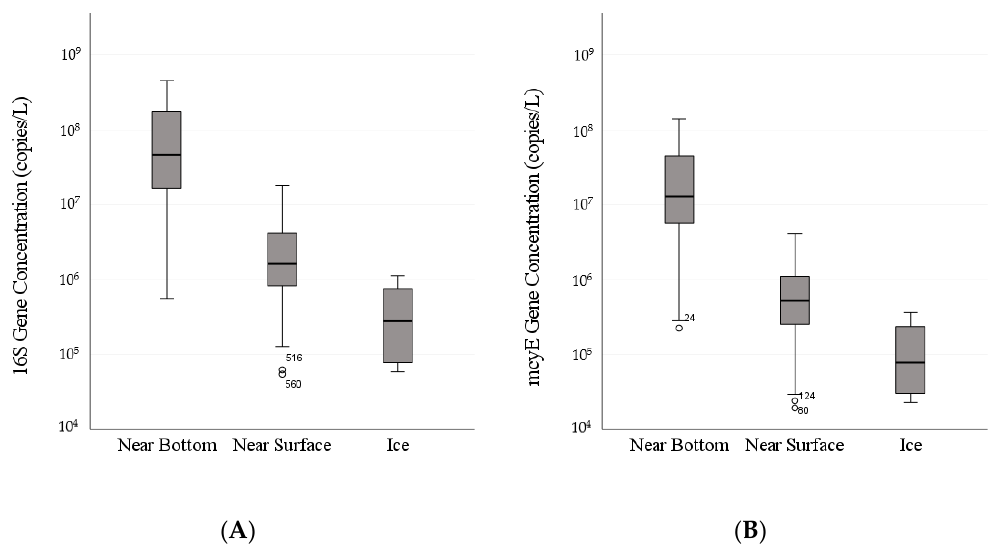
Figure 3. Concentrations of M. aeruginosa 16S rRNA ( A ) and mcyE ( B ) gene copies in the near-bottom, near-surface, and ice cover from 7 February to 12 March 2019, at the Gilmour Point, Dog Lake field site. Boxes represent the first to third quartile while whiskers represent 95% confidence intervals. Lines within boxes represent the median. Dots represent out- liers.